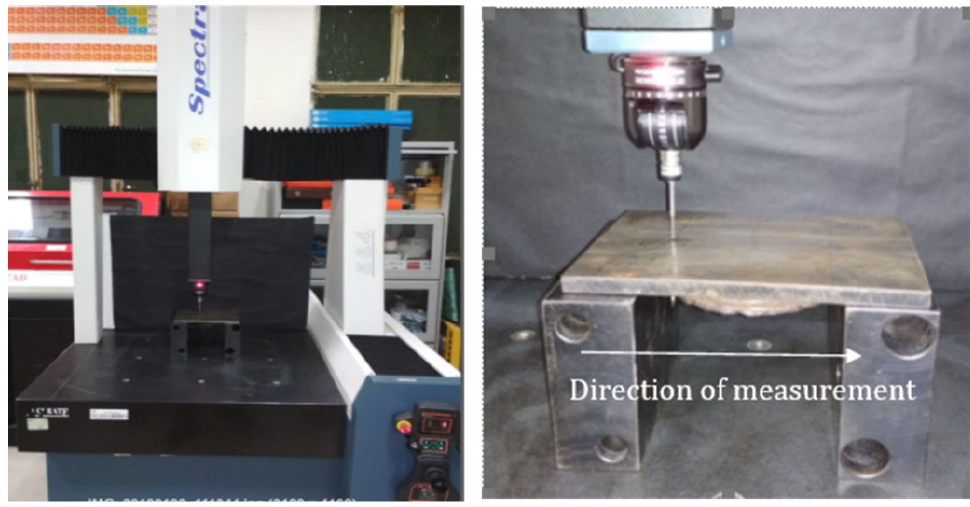
Figure 3. Distortion